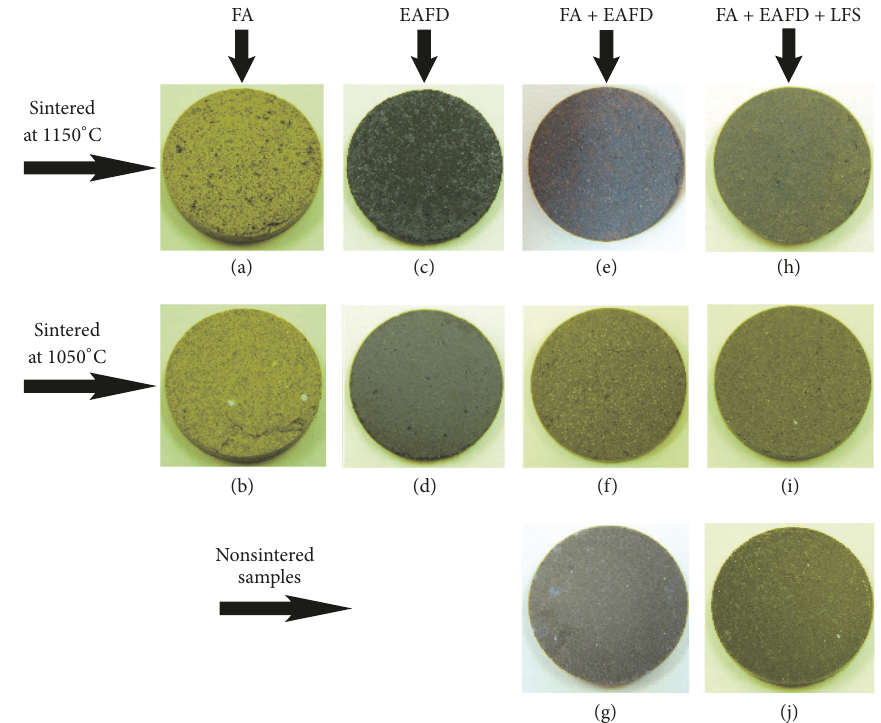
Figure 1: Selected photographs of the disc-shaped ceramic specimens (with diameter 13 mm) consisting of 100wt.% FA (a, b), 100wt.% EAFD (c, d), 50-50 wt.% FA + EAFD mixture (e, f, g), and 33,3-33,3-33,3 wt.% FA + EAFD + LFS mixture (h, i, j). Sintered samples at 1150 ∘ C (a, c, e, h), 1050 ∘ C (b, d, f, i), and nonsintered samples (g, j) are shown from top to bottom,